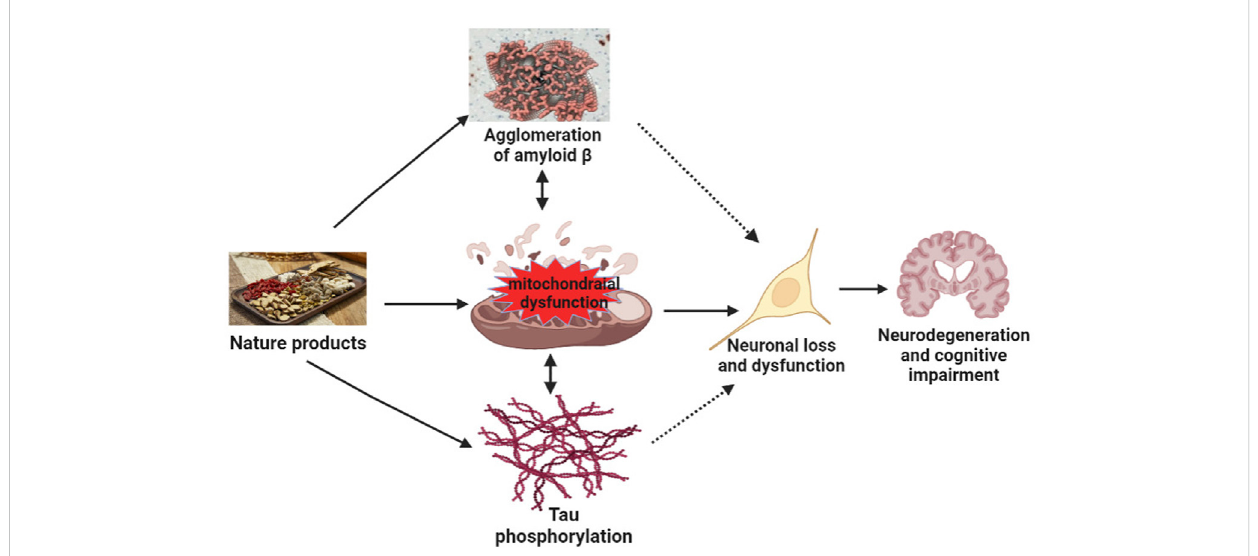
FIGURE 3 Mechanismsofnaturalproductstargetmitochondrialfunctiontoimproveneurodegenerationandcognitiveimpairment.Mitochondrialdysfunction resultsintheagglomerationofA β ,tauphosphorylation,andagglomerationofA β andtauphosphorylation,furtheraggravatingmitochondrialdysfunction, leadingto neuronal lossordysfunction,andultimatelyinducing neurodegenerationand cognitive impairment. Natural products actonthemitochondria to improve tau phosphorylation and the agglomeration of amyloid β , neuronal loss, and dysfunction, thereby improving neurodegeneration and cognitive